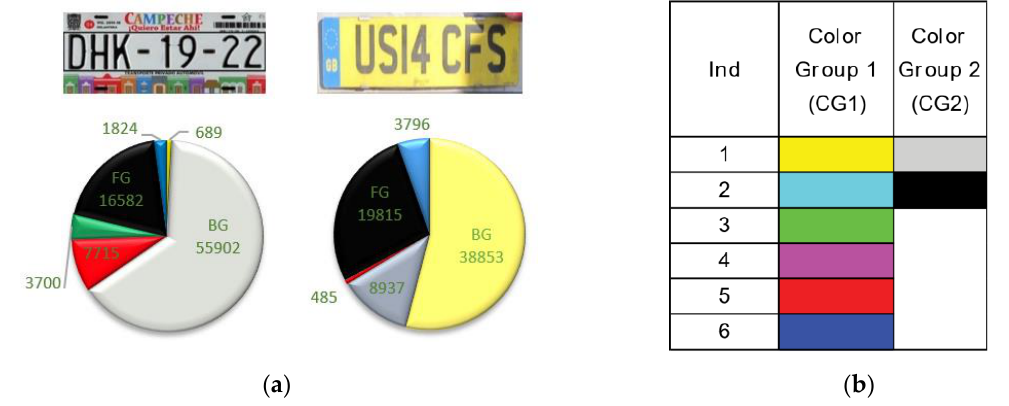
Figure 5. Foreground polarity detection based on colors: (a) foreground (FG)/background (BG) detection based on colors candidates count, (b) Color priority sequence.